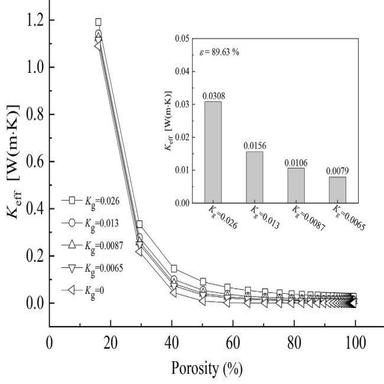
The relationship between thermal conductivity and porosity of MFW_11110 fractal structure under different Kg value.